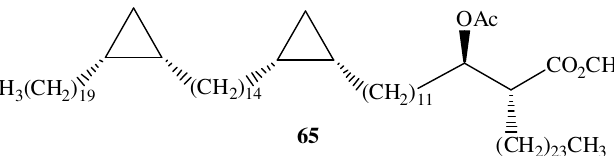
FIGURE 5. Mycolic acid 65 synthesized by Baird and